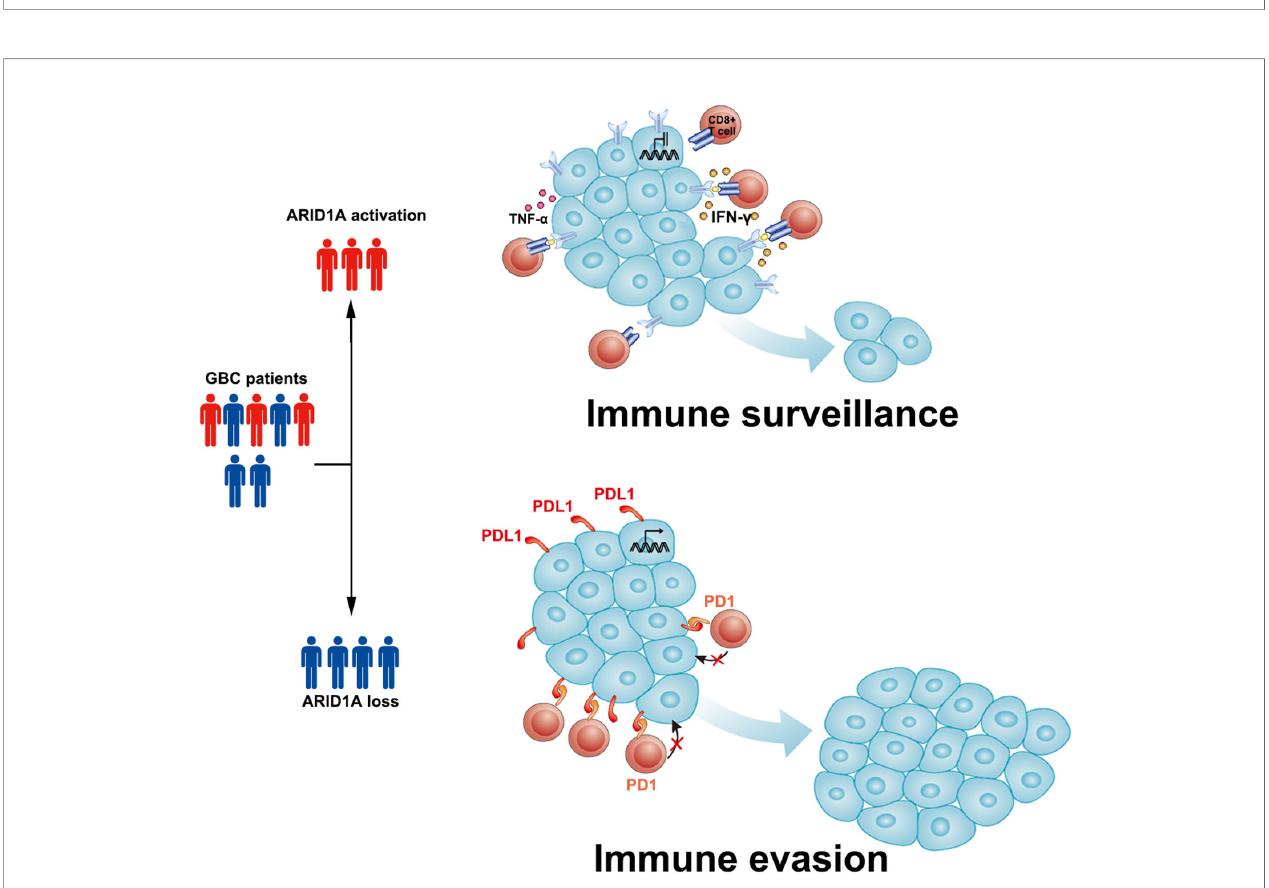
FIGURE 5 | Sketch map depicting the role of AT-rich interactive domain 1A (ARID1A) in patients with gallbladder cancer (GBC). We propose that in ARID1A- activated GBC, the relatively low expression of PD-L1 allows tumor-in fi ltrating lymphocytes (TILs) to function normally and perform immune surveillance. In ARID1A- inactivated GBC, the upregulation of PD-L1 in tumor cells might lead to immune evasion in the tumor microenvironment via the PD1/PD-L1